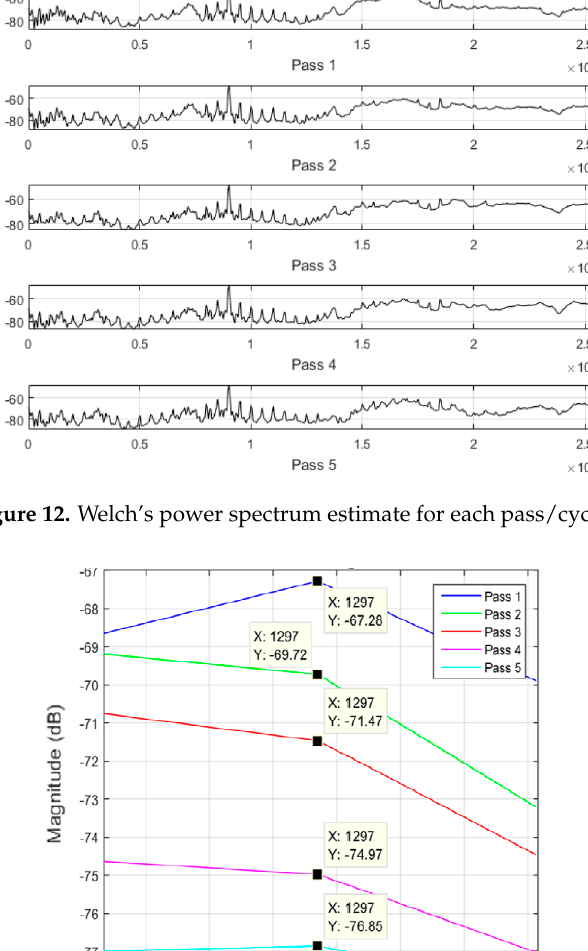
Figure 13. Vibration signal in X direction.